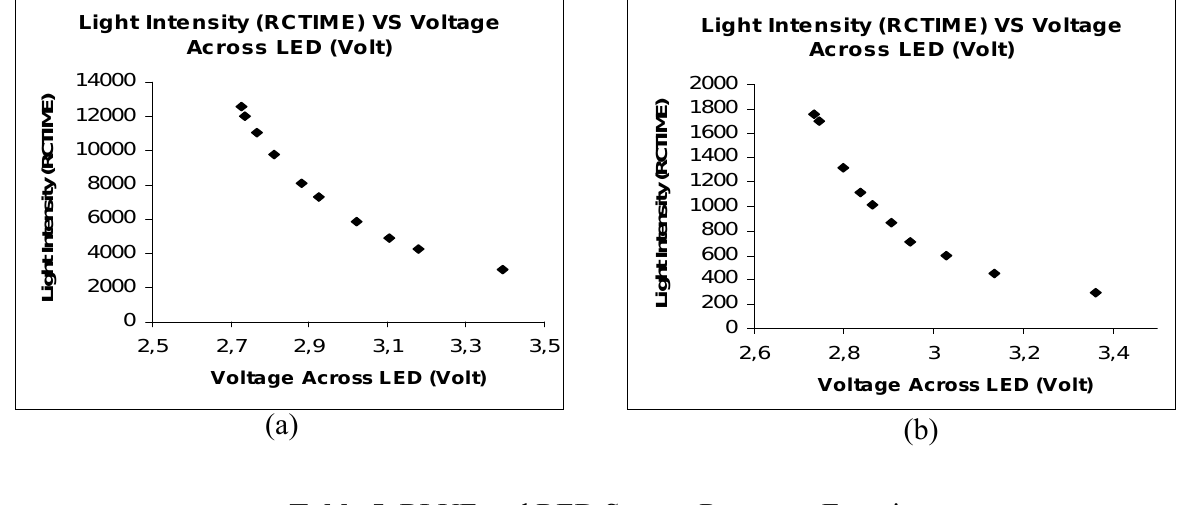
Table 5. BLUE and RED System Response